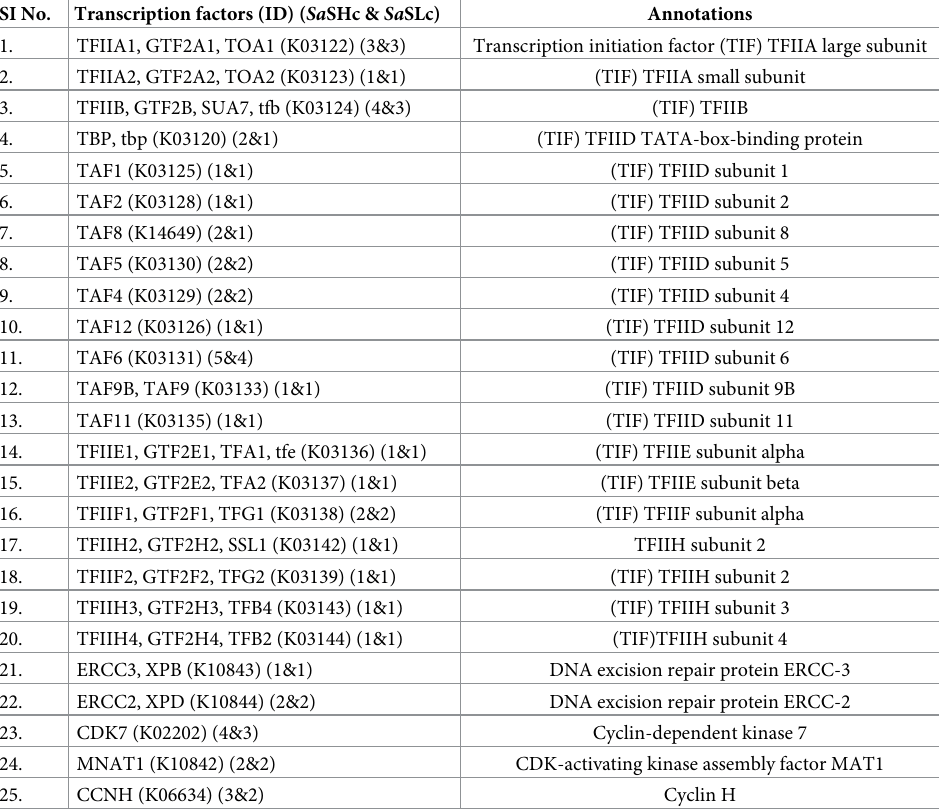
Table 9. List of transcription factors and genes encoding key enzymes for sandalwood oil biosynthesis whose expressions were altered in high oil ( Sa SHc) and low oil yielding ( Sa SLc) sandalwood ( S . album